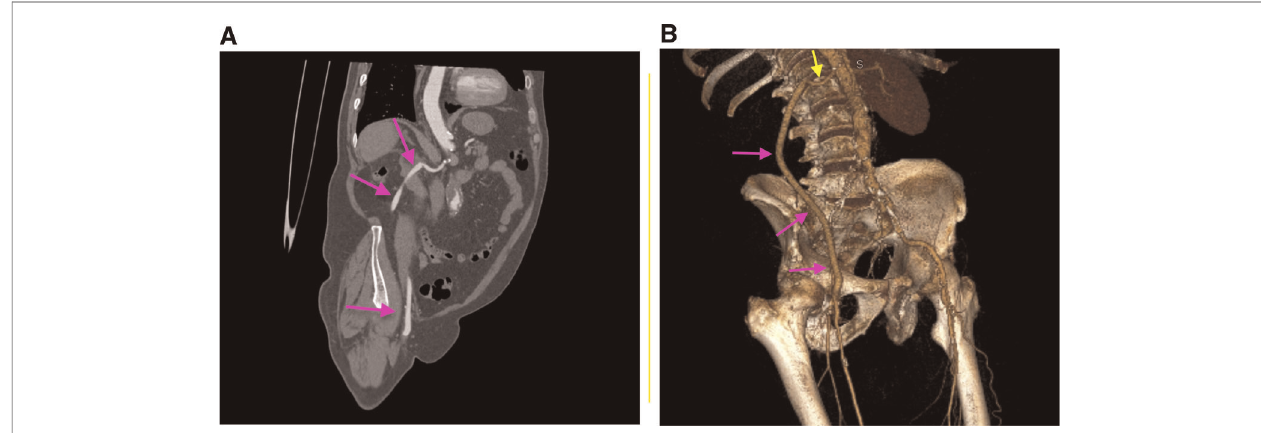
FIGURE 3 | CT angiographic after surgery: coronal section, purple arrows: reno-femoral permeable bypass ( A ) and 3D reconstruction, yellow arrow: right renal artery; purple arrows: reno-femoral permeable bypass ( B